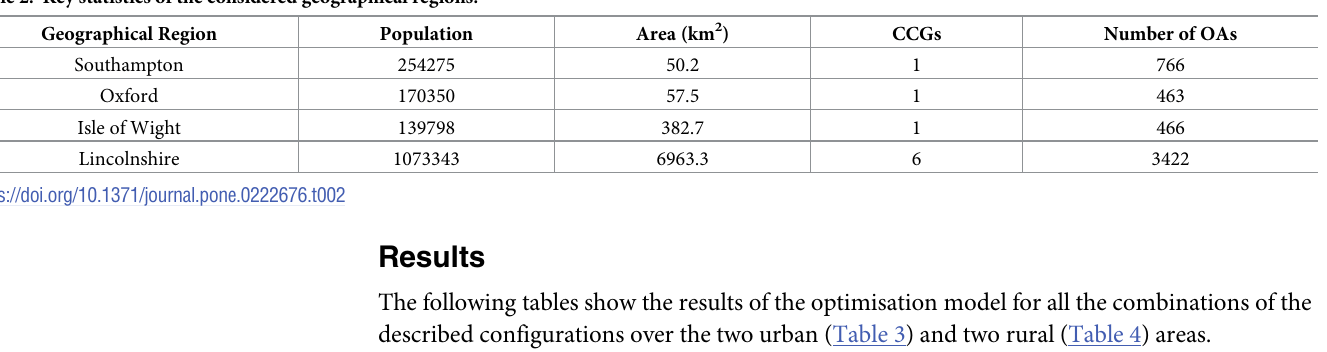
The following tables show the results of the optimisation model for all the combinations of the described configurations over the two urban (Table 3) and two rural (Table 4) areas.